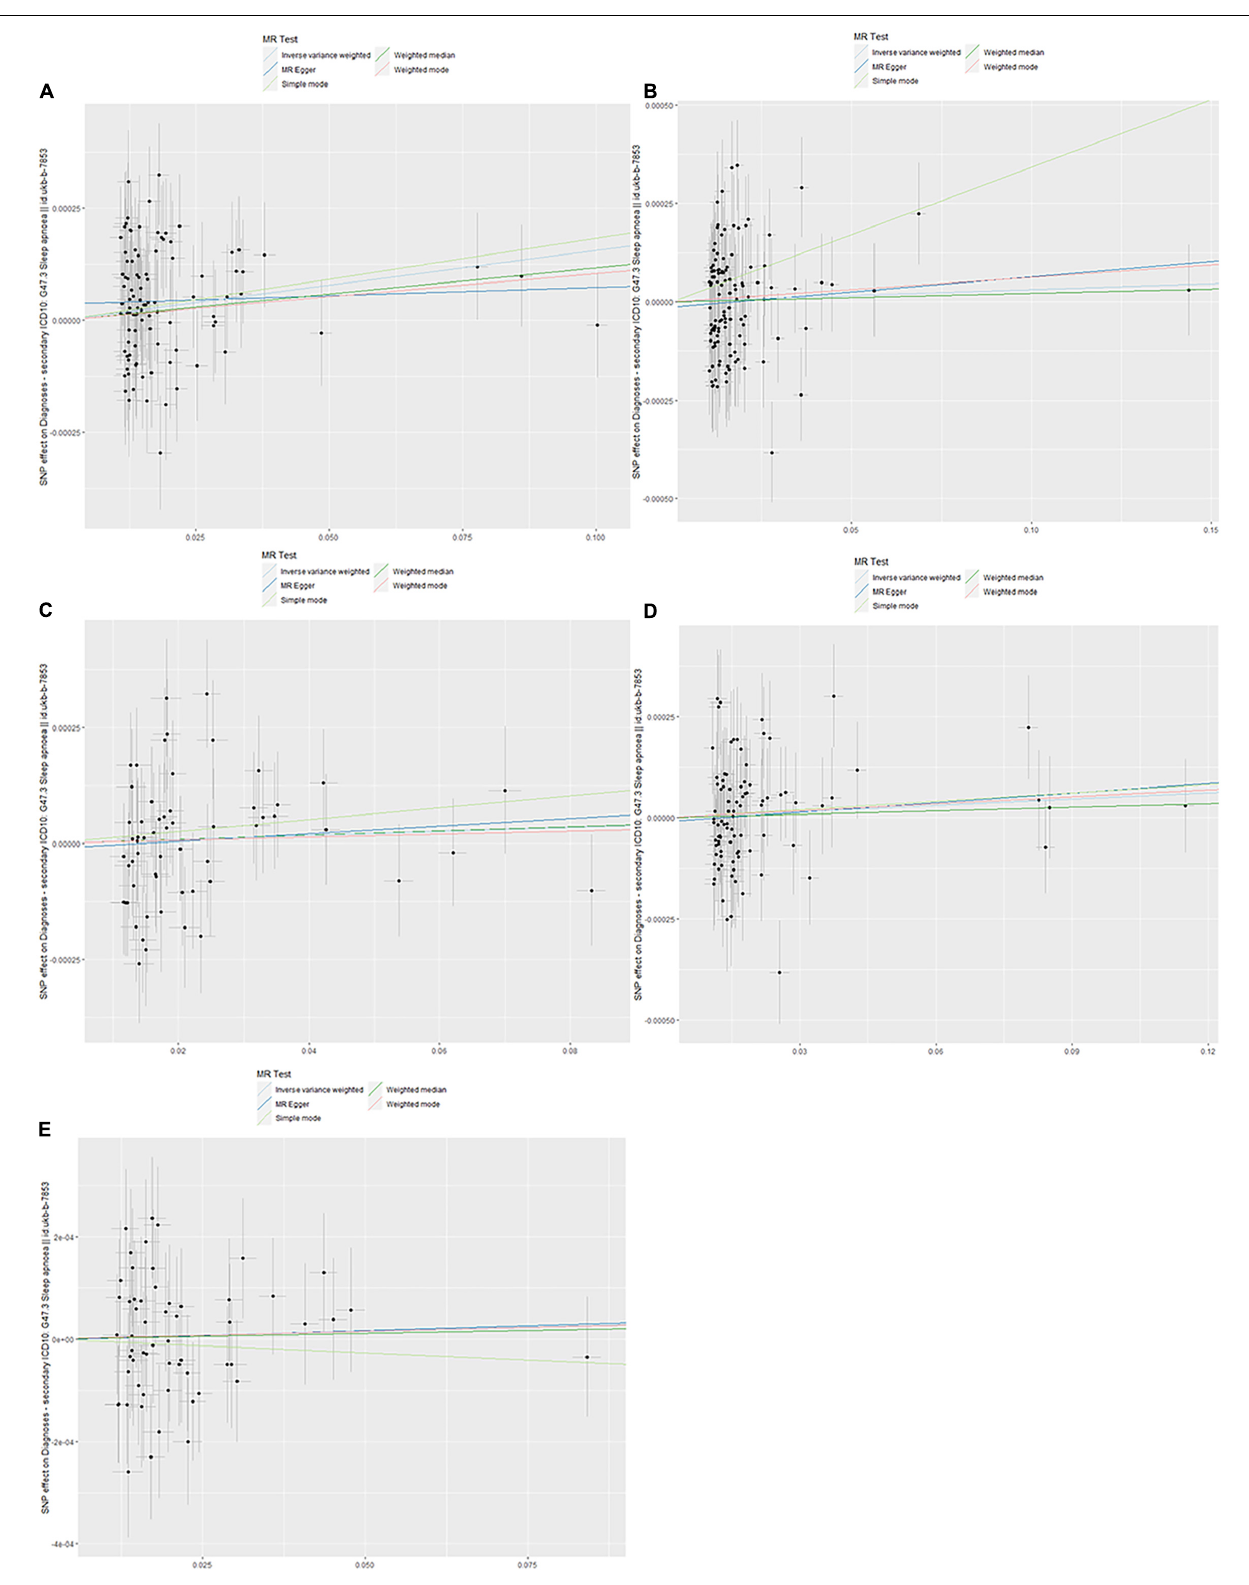
FIGURE 4 | Scanner plot. (A) Triglyceride, (B) high-density lipoprotein, (C) low-density lipoprotein, (D) apolipoprotein A-1, and (E) apolipoprotein B.